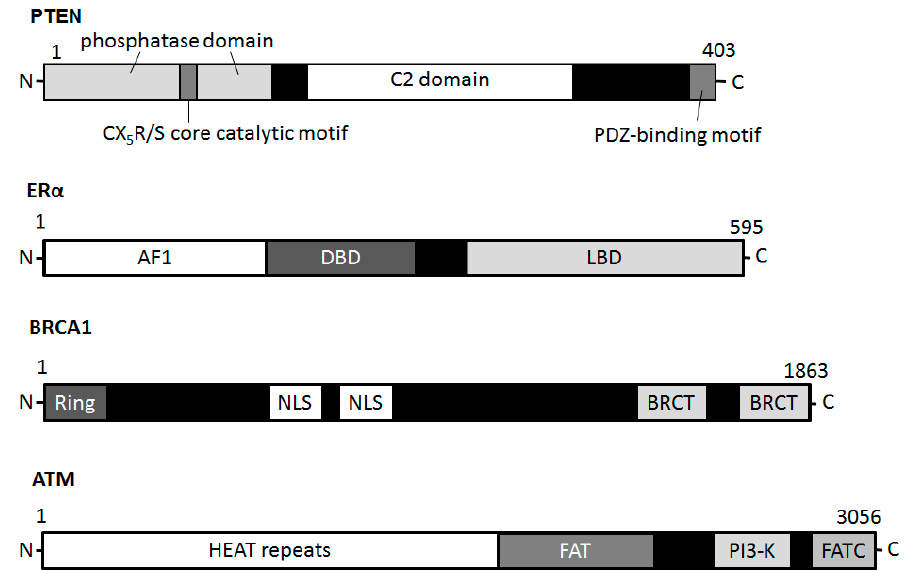
Figure 2. Schematic diagram indicating the domain structures of the PTEN, ER α , BRCA1, and ATM proteins. Note that the sizes of molecule are modified for clarity. PH domain = pleckstrin homology domain; C2 domain = a protein structural domain involved in targeting proteins to cell membranes; PDZ = a common structural domain in signaling proteins (PSD95, Dlg, ZO-1, etc .); AF1 = activation function 1; DBD = DNA-binding domain; LBD = ligand-binding domain; Ring = (Really Interesting New Gene) finger domain; NLS = Nuclear Localization Signal; BRCT = BRCA1 C Terminus; HEAT = huntington, elongation factor 3, a subunit of PP2A and TOR1; FAT = FRAP-ATM-TRRAP; FATC =